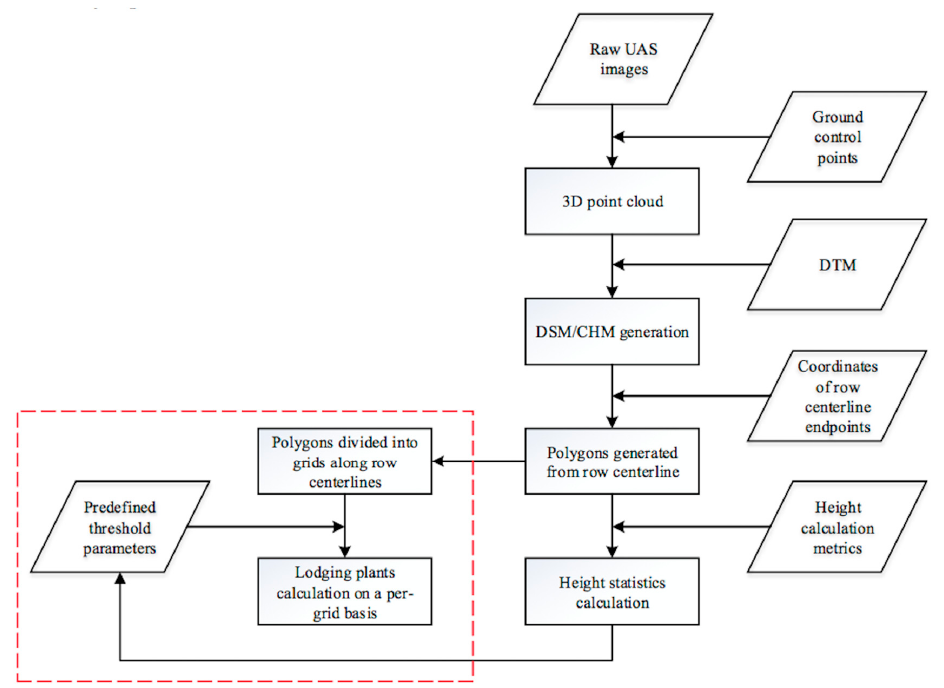
Figure 5. Overall flowchart of the grid-based lodging estimation method.